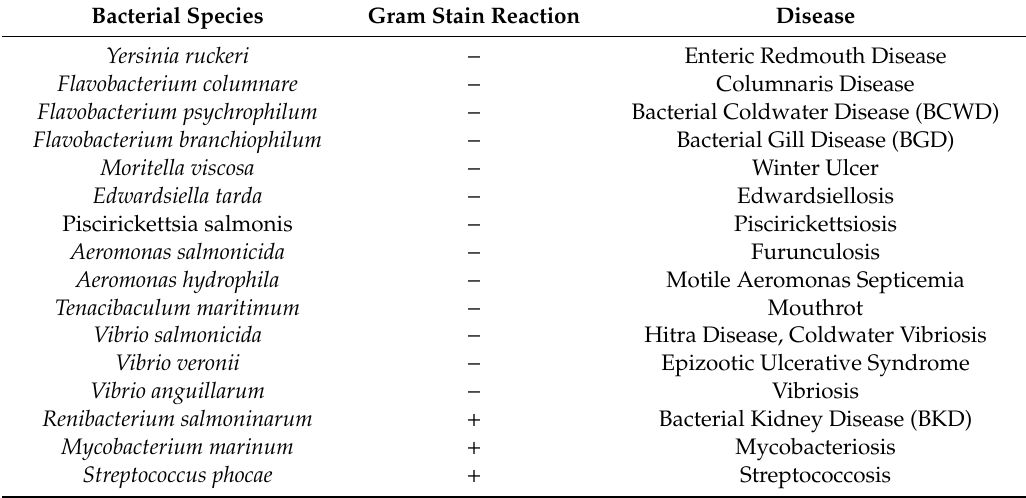
Table 1. Common bacterial pathogens in salmonid aquaculture. A list of bacterial pathogens that a ff ect the aquaculture production of salmonids, their Gram reaction and the diseases / conditions that they are associated with. Several of these conditions will be discussed throughout this review in order to describe various methods used in aquaculture to prevent and / or treat. The “ − ” symbol denotes a negative Gram reaction while the “ + ” symbol denotes a positive Gram